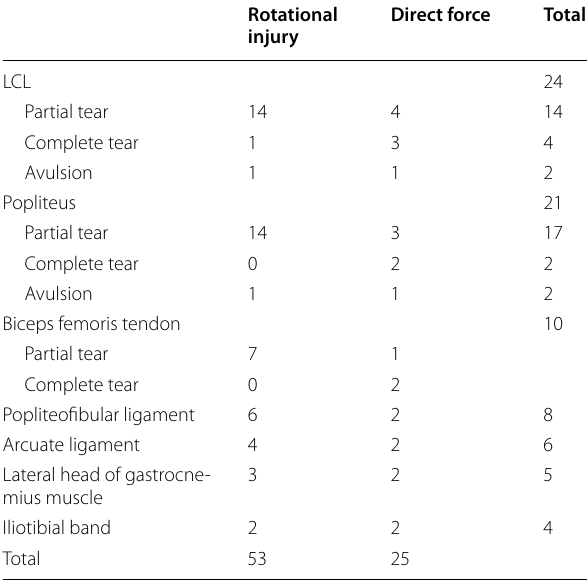
Table 3 Incidence of different PLC structures affected in relation to mechanism of